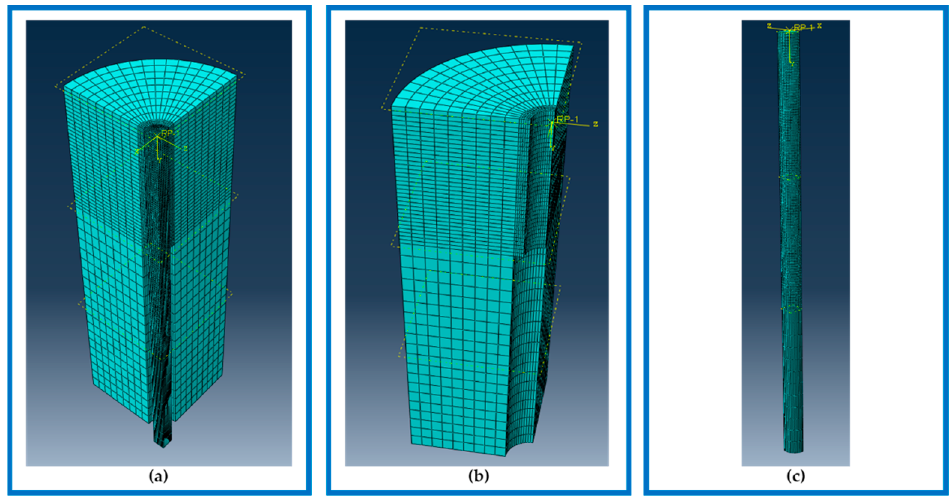
Figure 4. Mesh of a simulation mode: ( a ) quarter of specimens, ( b ) quarter of concrete, and ( c ) quarter of steel bar.